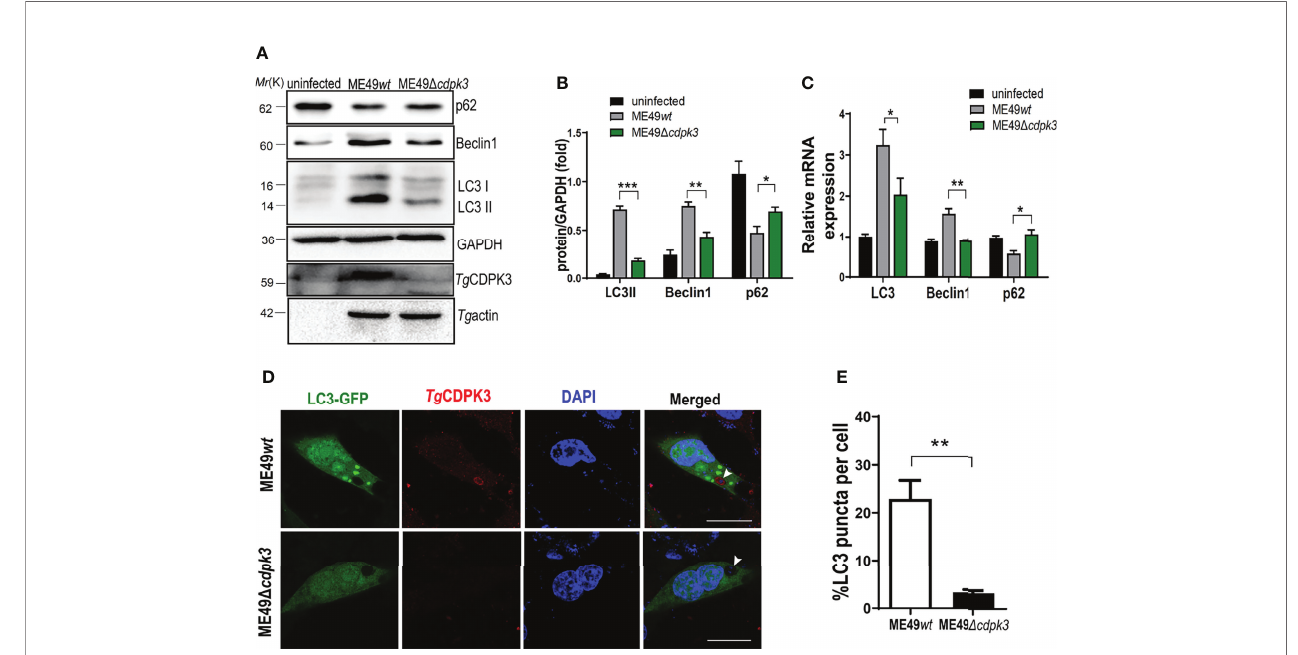
FIGURE 3 | ME49 D cdpk3 attenuates the activation of autophagy. (A, B) ME49 wt and ME49 D cdpk3 strain infected RAW264.7 cells for 24 h. Then the cell lysates were analyzed by western blot using indicated antibodies. GAPDH was used as a loading control. (C) RAW264.7 cells were infected with ME49 D cdpk3 and ME49 wt strains. After 24 hours, the RNA expression level of autophagy status was analyzed by real-time quantitative PCR (RT-qPCR). GAPDH was used as a loading control. (D, E) Cells grown on glass coverslips were transfected with LC3-GFP (green) and then infected with ME49 wt strain and ME49 D cdpk3 for 24 hours. Double immuno fl uorescence was performed using anti-CDPK3(red) and DAPI (DNA, blue) (Scale bar:10 m m). A distinctive intensity of LC3-GFP was observed in ME49 wt strain infected cells. Data are mean ± SD of triplicates. Statistical differences are represented by ***p < 0.001, **p < 0.01, *p < 0.05 (n = 3 each